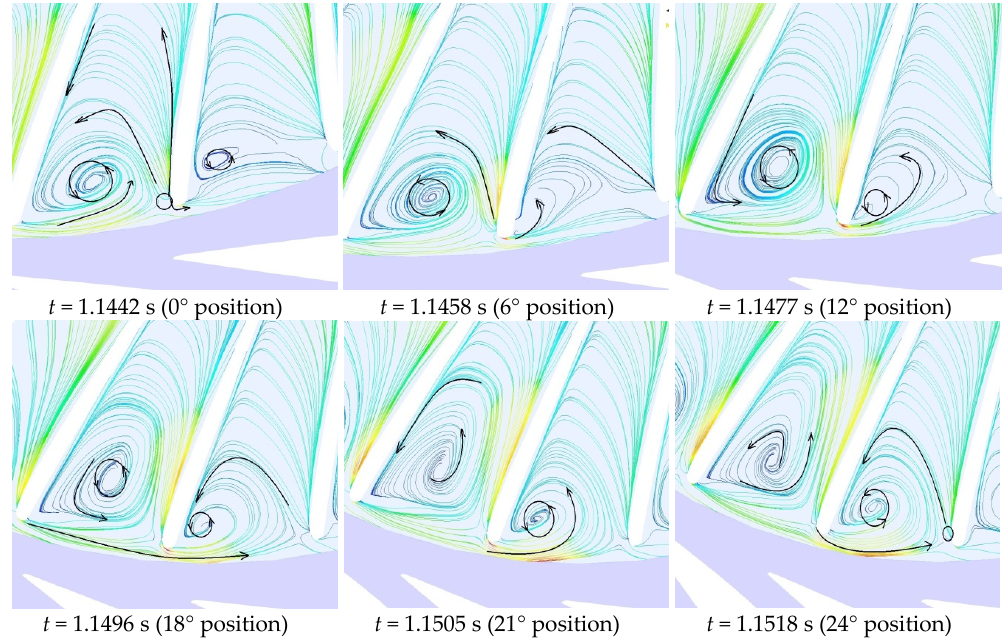
Figure 16. Time-dependent variation in the flow field on the runner surface crown during an angular movement of the runner of 24 ˝ at the runaway speed ( α = 9.9 ˝ ); this zoom of the rectangle marked in Figure 16 for the passage includes the blade pressure side, the splitter suction side, the splitter pressure side and the blade suction side; the streamlined color scale is similar to Figure 15 in the rotating frame of reference.